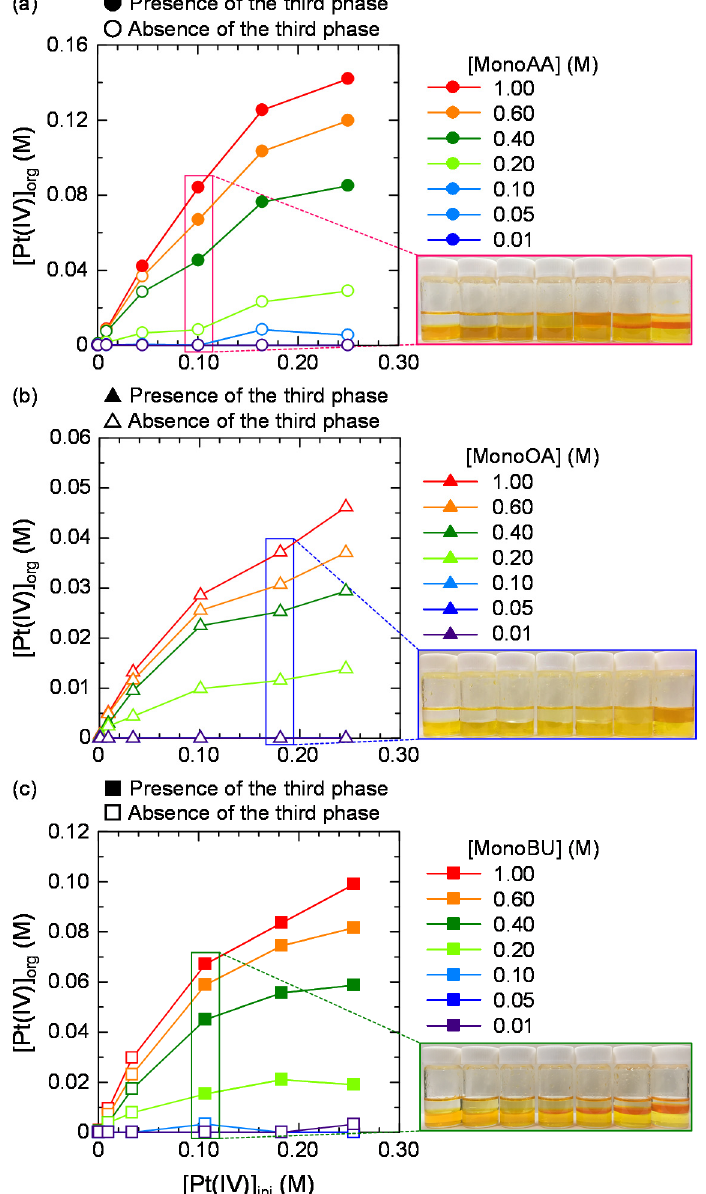
Figure 7. Effect of initial Pt(IV) and extractant concentrations on the third phase formation during Pt(IV) extraction by ( a ) MonoAA, ( b ) MonoOA, and ( c ) MonoBU. [Extractant] org,i = 0.01–1.0 M in n -dodecane/2-ethylhexanol (80 vol%/20 vol%), [Pt(IV)] aq,i = 0.001–0.274 M, [HCl] aq,i = 2.0 M.